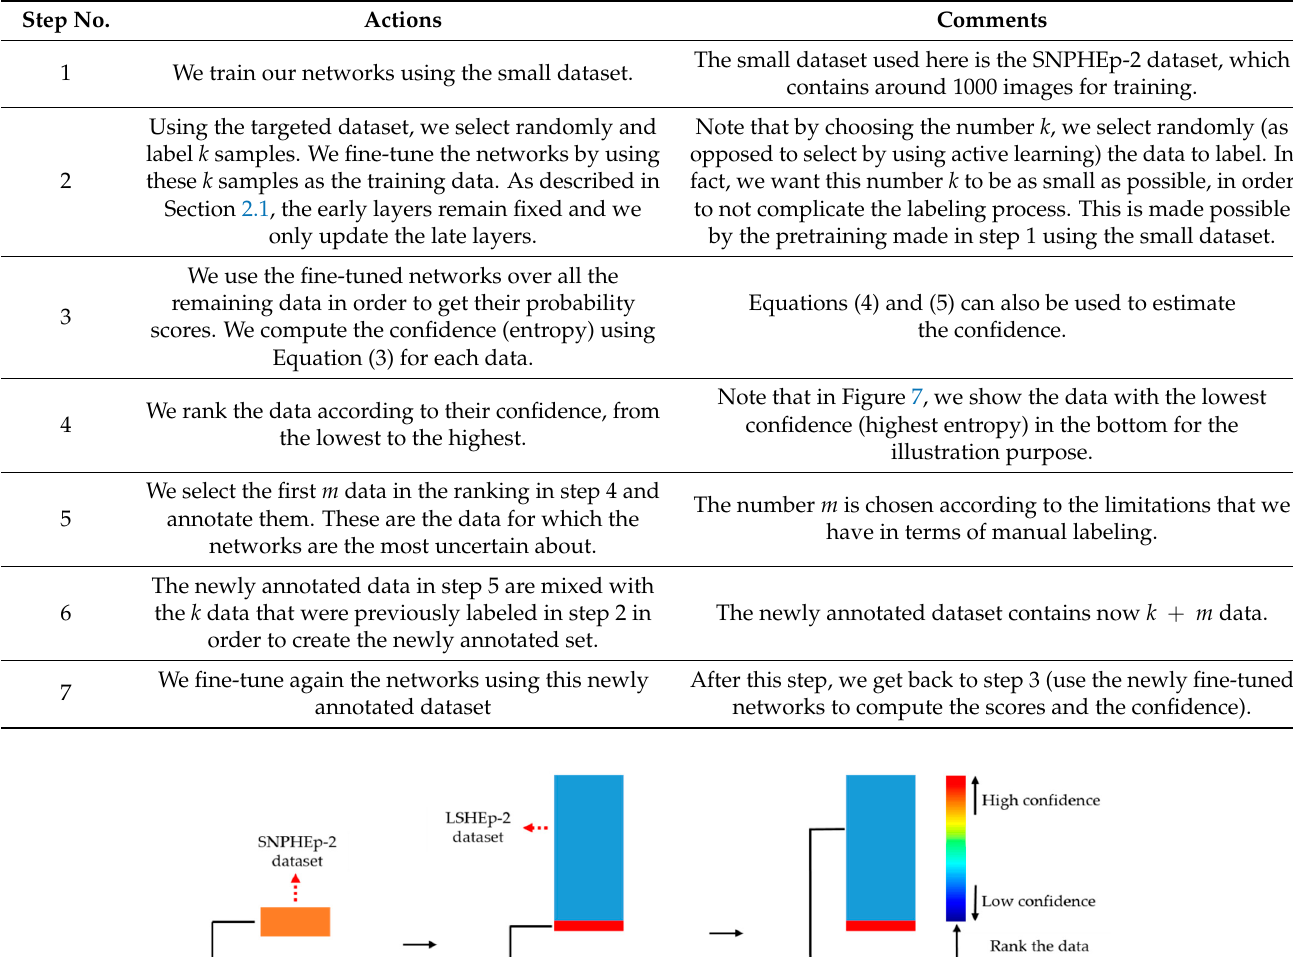
Table 1. The different steps of our active learning scheme.